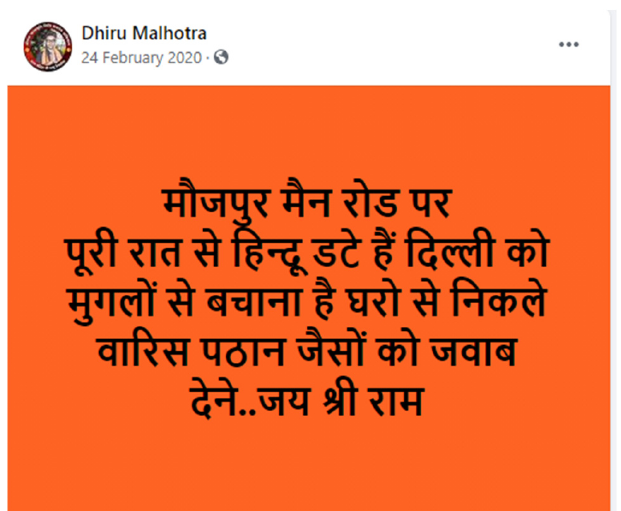
Figure 3. Facebook post inciting people to come out onto the streets. “Hindus are guarding the Maujpur main road. Get out of homes to save Delhi from the Mughals...Jai Shri Ram”.